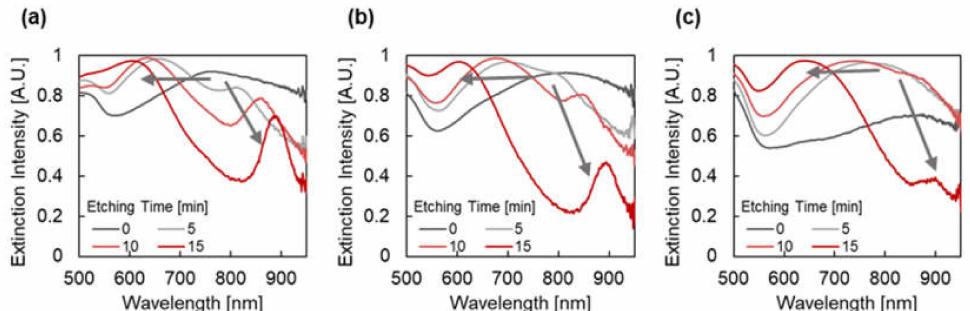
Figure 5. Extinction spectra of plasmonic devices fabricated by depositing Au with a thickness of ( a ) 100 nm, ( b ) 150 nm, and ( c ) 200 nm under dry conditions. The chart series in the graphs indicate the etching time (min), and the gray arrows in the graphs indicate the shift of extinction peaks.